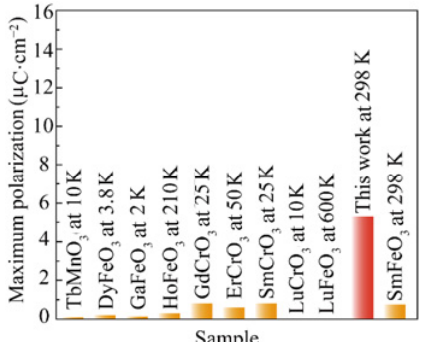
Fig. 11 Comparison between P and testing temperatures of different orthoferrites (TbMnO 3 [52], DyFeO 3 [17], GaFeO 3 [53], HoFeO 3 [54], GdCrO 3 [55], ErCrO 3